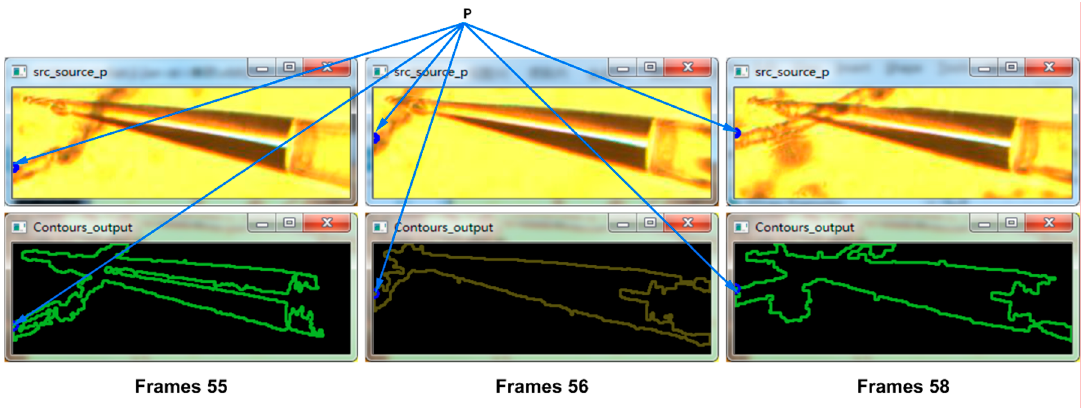
Figure 22. Failure ISME tip locations.